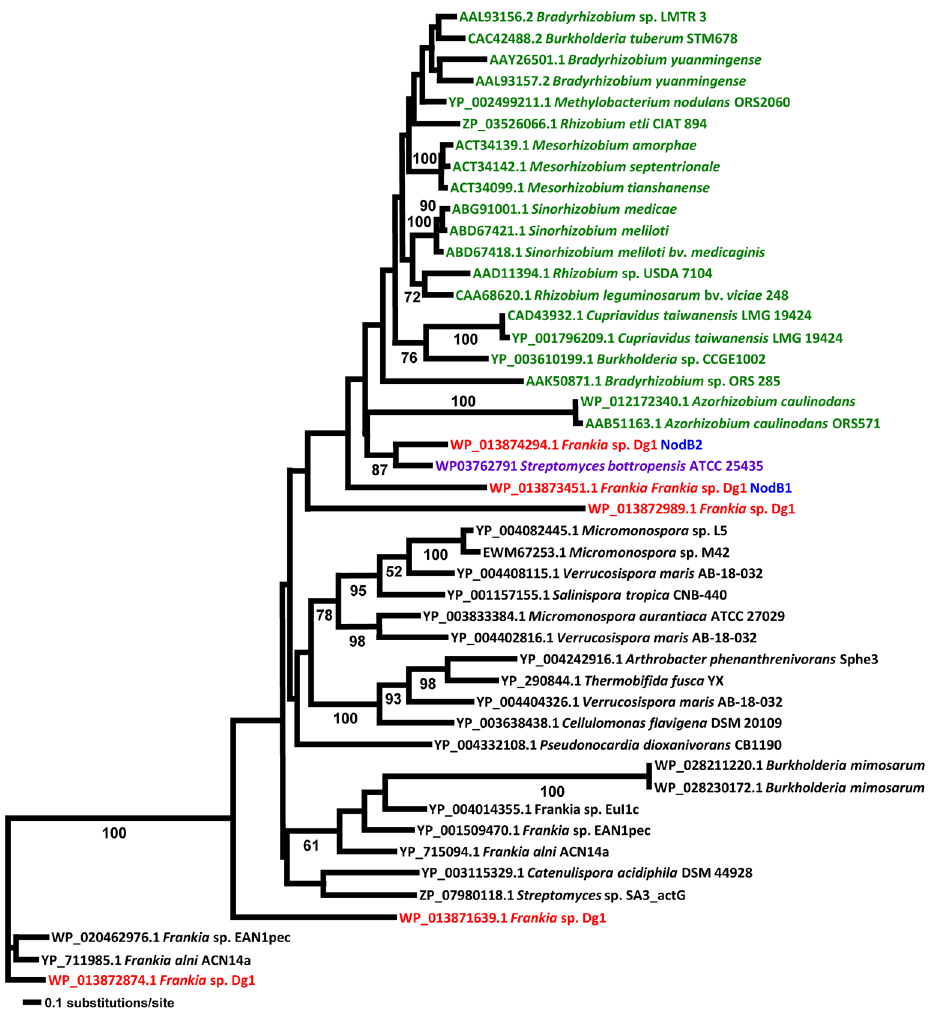
Fig 3. Maximum Likelihood trees NodB proteins. All rhizobial sequences are given in green, all sequences from Dg1 are given in red, sequences from Streptomyces bottropensis are given in purple. Dg1 NodB1 and NodB2 sequences are indicated in blue. All sequences used for the phylogenetic analysis are given in S6